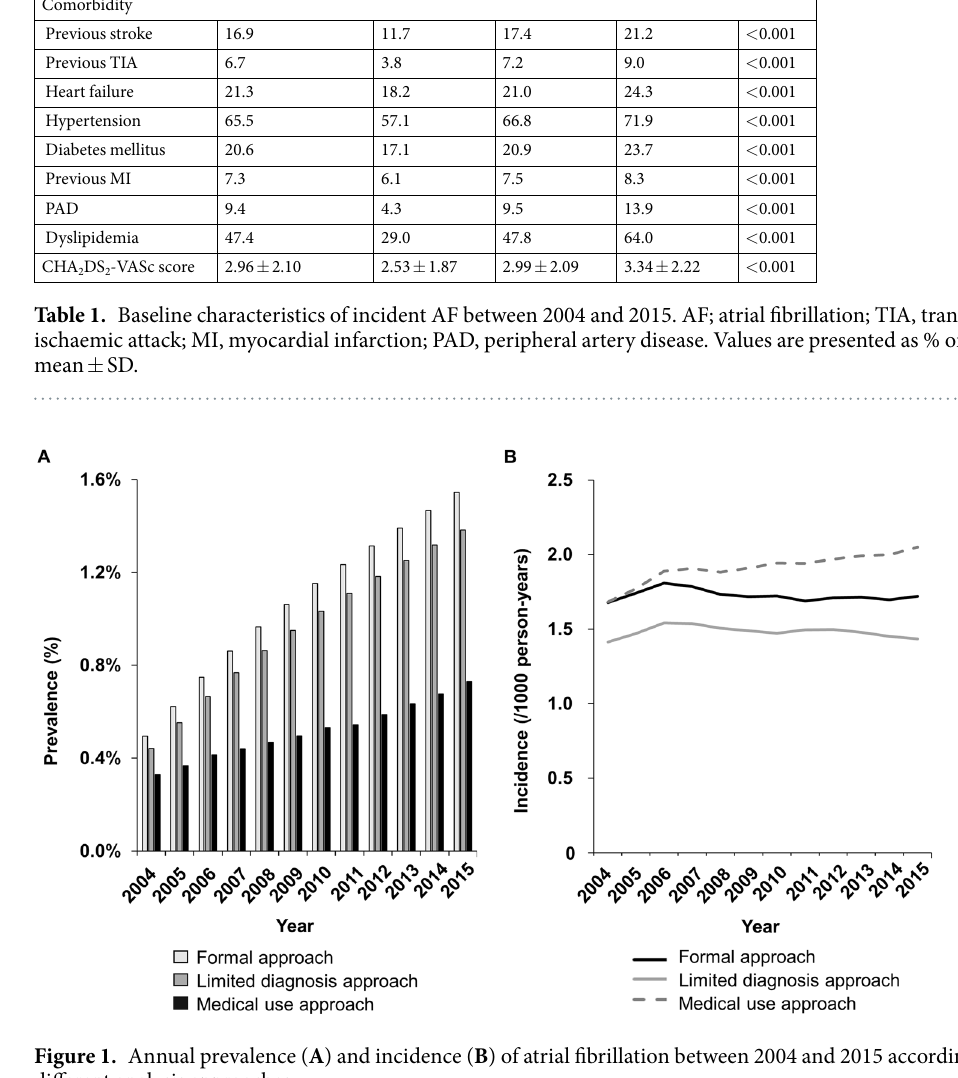
Figure 1. Annual prevalence ( A ) and incidence ( B ) of atrial fibrillation between 2004 and 2015 according to different analysis